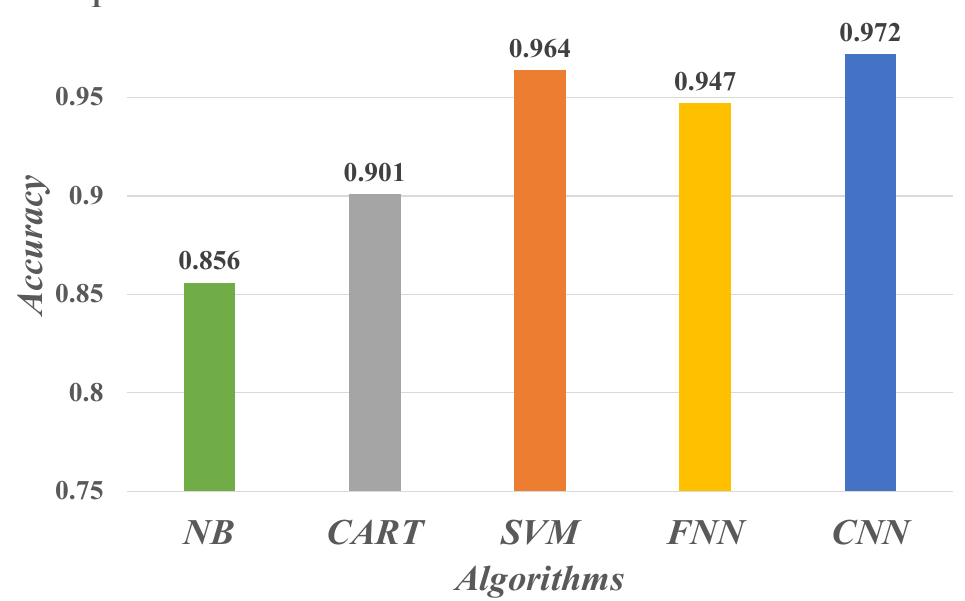
Figure 10. Performance of different machine learning algorithms for tumor staging prediction of NSCLC.